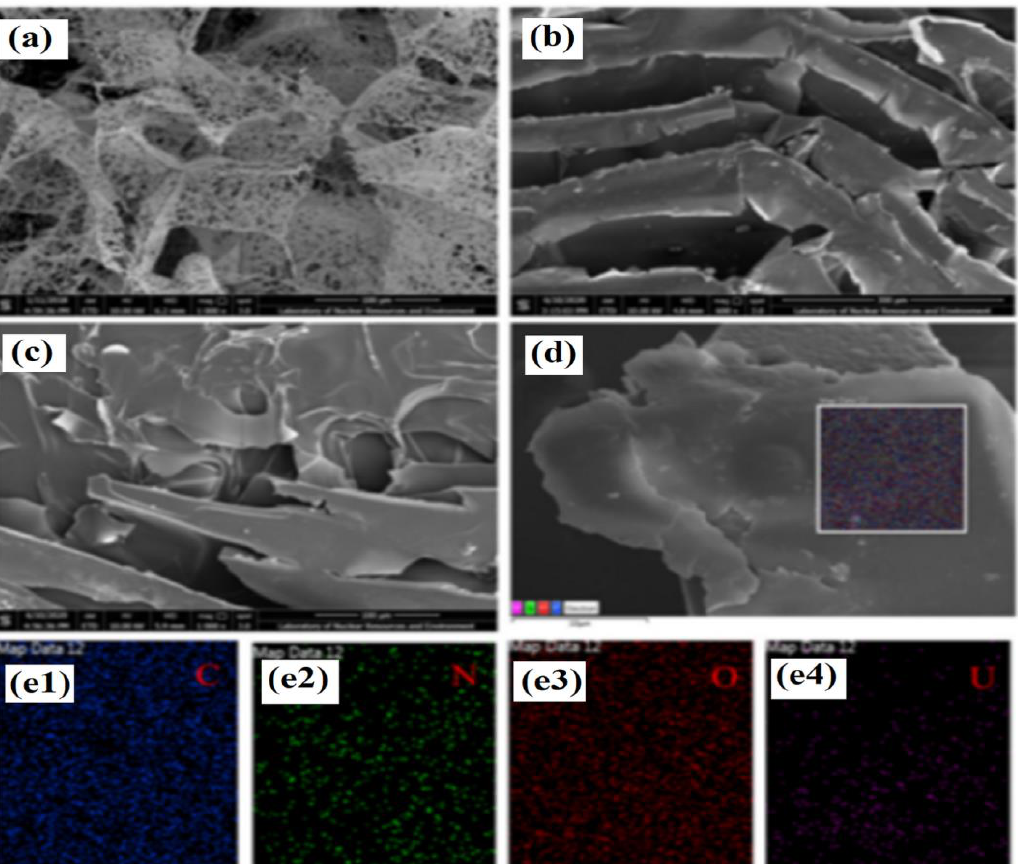
Figure 6. Scanning electron micrographs of ion imprinted ( a , c , d ) and non-imprinted ( b ) chitosan foam together with elemental mapping (( e1 – e4 ), for carbon, nitrogen, oxygen, and uranium, represents material after loading with uranium ions). Adapted with permission from Reference [96]. Elsevier, 2020.